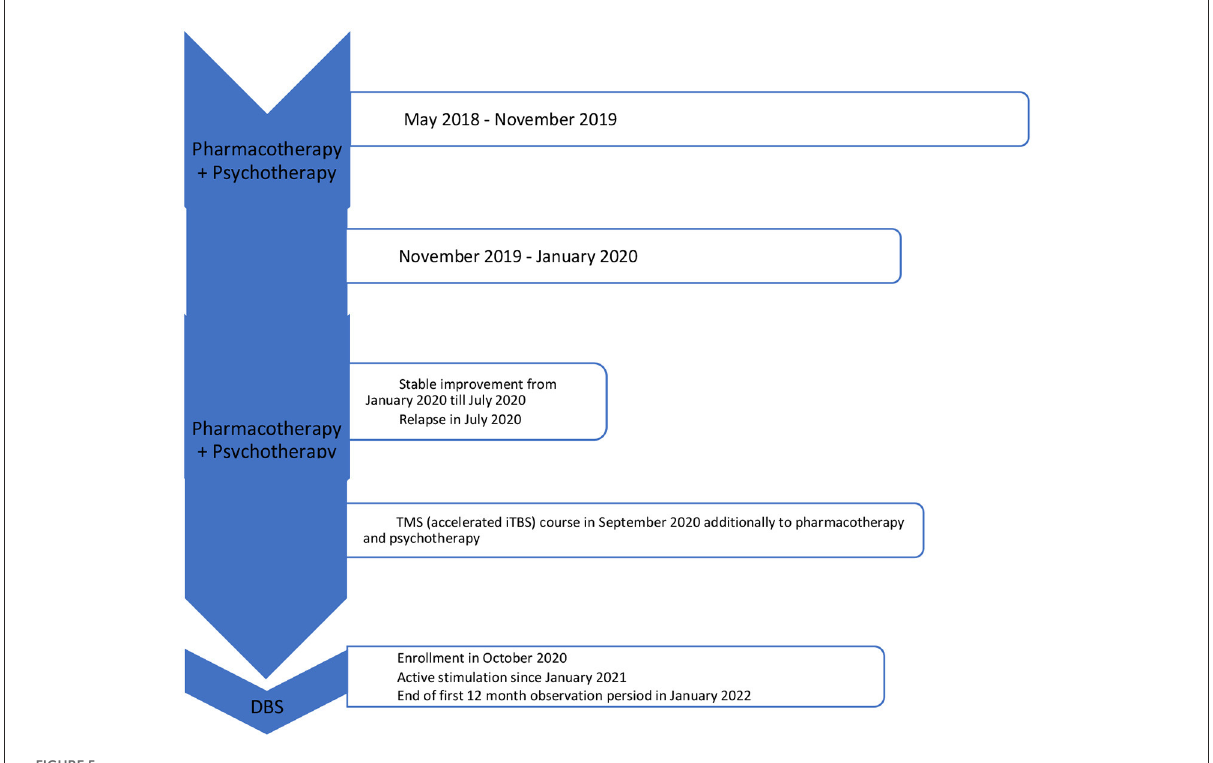
FIGURE5 Timeline of the